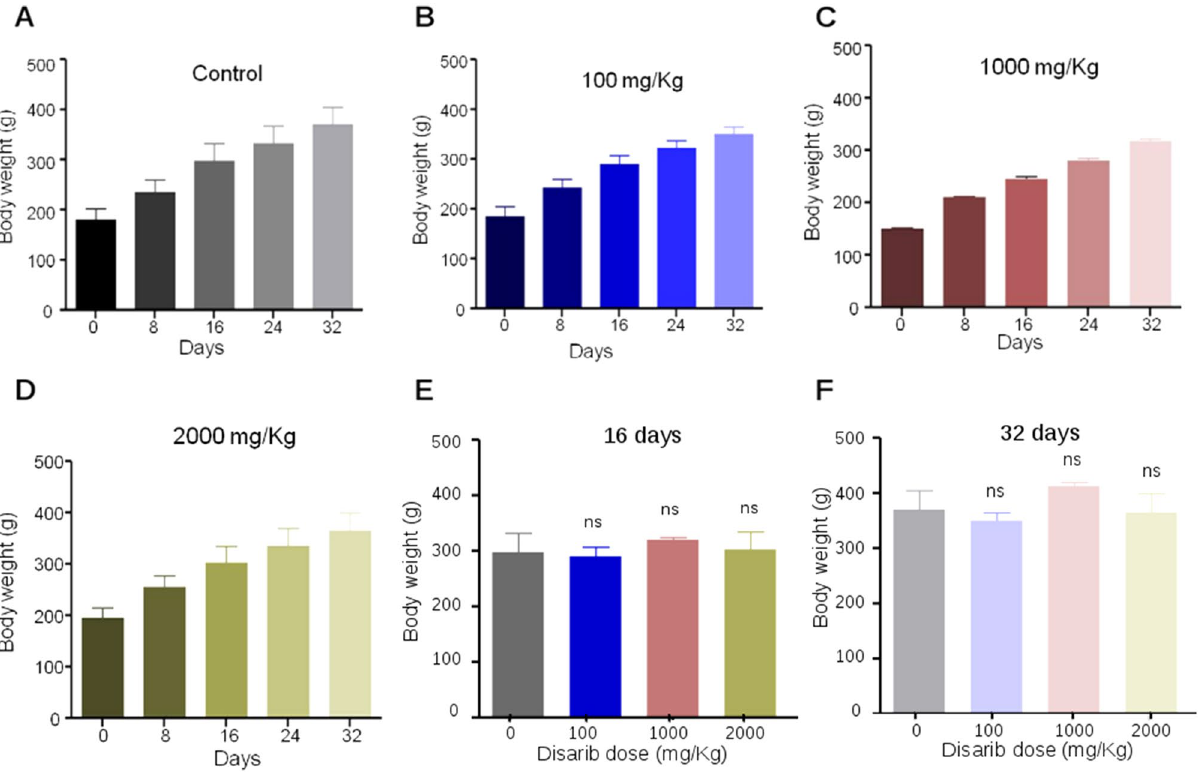
Figure 4. Single-dose toxicity studies of Disarib in Wistar rats. ( A – D ) Body weight analysis of rats on 0, 8, 16, 24, 32 days after oral administration of vehicle control (carboxymethyl cellulose) ( A ), low dose (100 mg/kg) ( B ), intermediate dose (1000 mg/kg) ( C ) and high dose (2000 mg/kg) ( D ) of Disarib. ( E , F ) Comparison of change in body weight among control and treated groups after 16 days ( E ) and 32 days ( F ). Five rats per group were used for the study. Error bars denote mean + SEM ( ns not